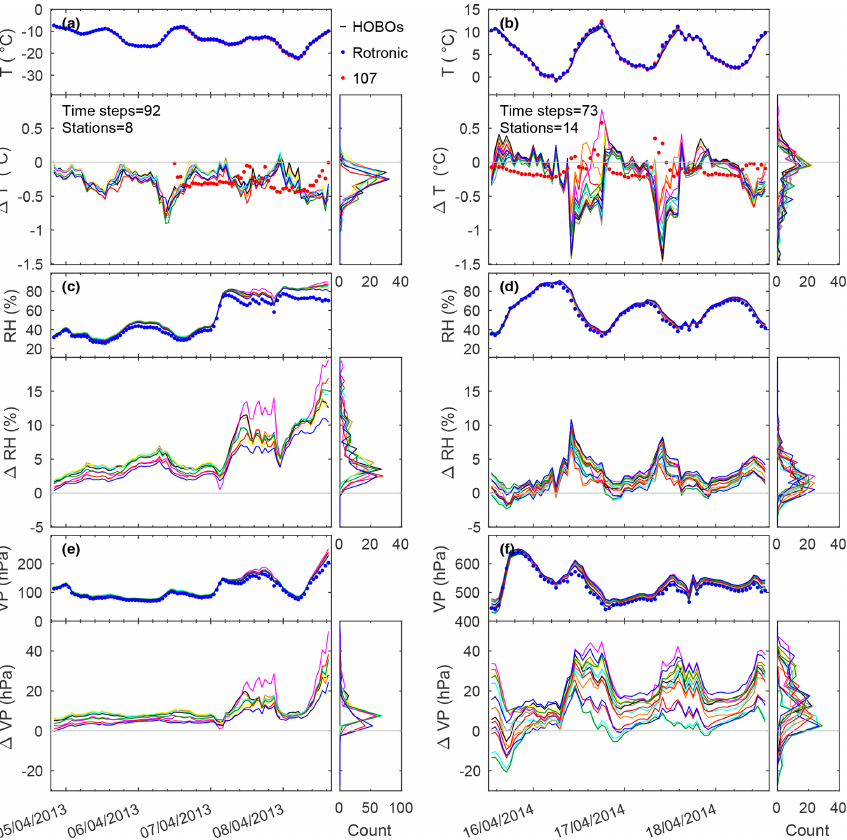
Figure 7. Time series of hourly air temperature T (a, b) , relative humidity RH (c, d) , and derived vapor pressure VP (e, f) of eight HOBO sensors during the calibration period in 2013 (a, c, e) and 14 sensors in 2014 (b, d, f) and their differences to the Rotronic reference sensor. Each colored line represents a HOBO sensor, blue dots are for the reference Rotronic sensor, and red dots are for a Campbell 107 temperature probe. Also shown is the count of differences between HOBO and reference values in bins of 0.1 ◦ C, 1%, and 5hPa.